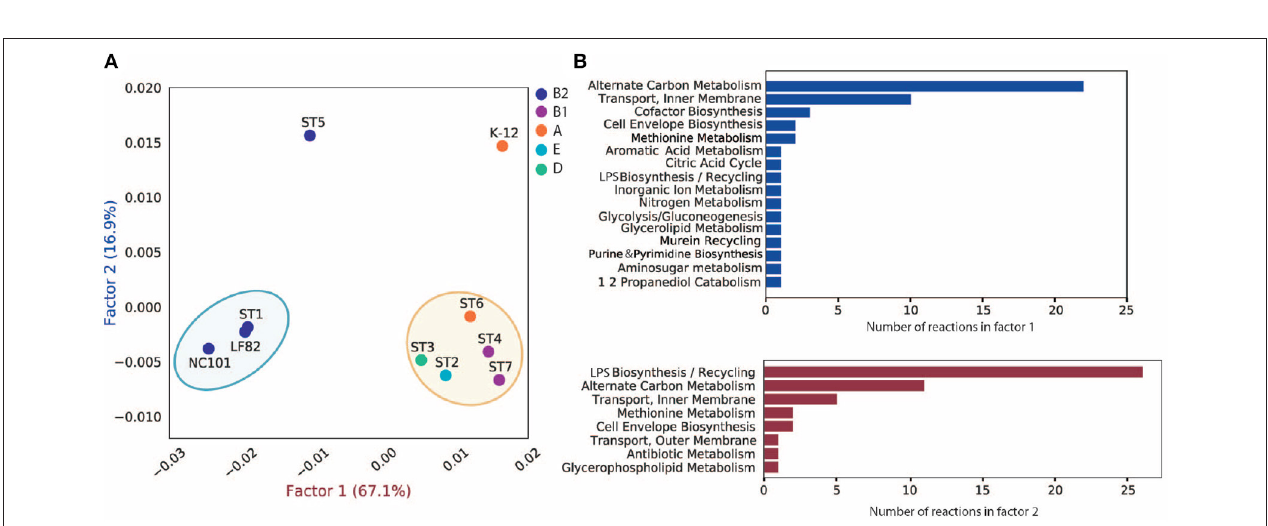
FIGURE 4 | MCA analysis of pan-reactome for ten strains. (A) Visualization of factor 1 and factor 2 of MCA results. (B) Functional distribution of important reactions in factor 1 and factor